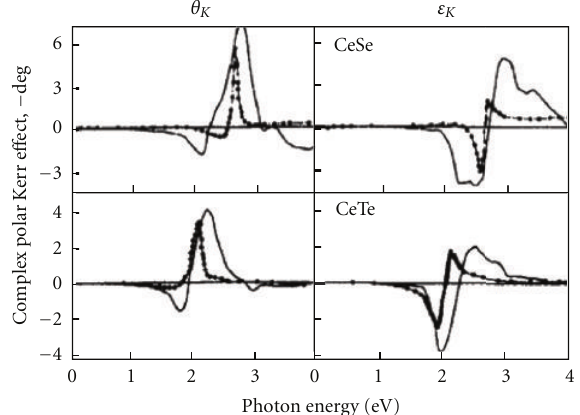
Kerr rotation peak of − 22 . 08 ◦ , − 5 . 51 ◦ , and − 3 . 32 ◦ detected